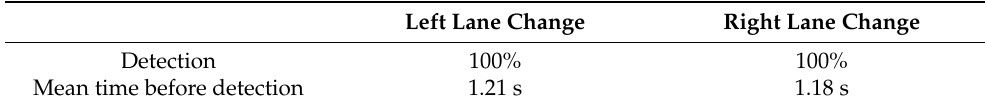
Table 1. Cut-In intention verification result.